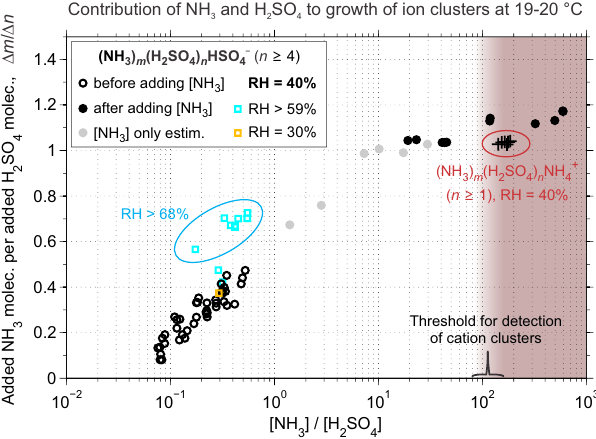
Figure 5. Number of gained NH 3 molecules per gained H 2 SO 4 molecule, (cid:49)m / (cid:49)n , plotted against the ratio of NH 3 and H 2 SO 4 gas-phase concentrations, [NH 3 ]/[H 2 SO 4 ], for particle formation experiments at 19 to 20 ◦ C, showing a positive correlation. Circles are for anion clusters (NH 3 ) m · (H 2 SO 4 ) n · HSO − and experiments 4 at a relative humidity (RH) of 37% to 40%. Colored squares denote experiments at lower RH (30%) or higher RH (>59%). Red pluses show (cid:49)m / (cid:49)n for cation clusters (NH 3 ) m · (H 2 SO 4 ) n · NH + , 4 which are only observed at sufficiently high [NH 3 ]/[H 2 SO 4 ], as indicated by the red-shaded area, at an RH of 39% to 40%. Val- ues for (cid:49)m / (cid:49)n were determined for anion clusters in the range 4 ≤ n ≤ 18 ∗ , and for cation clusters in the range 1 ≤ n ≤ 16 ∗ . The lower limits of these ranges correspond to the sizes, from which onward (cid:49)m / (cid:49)n were constant. The upper limits were chosen, be- cause up to these sizes a good signal was obtained for most experi- ments. ∗ Actual upper limits varied depending on obtained signals. The median maximum n was 16 for both anion and cation